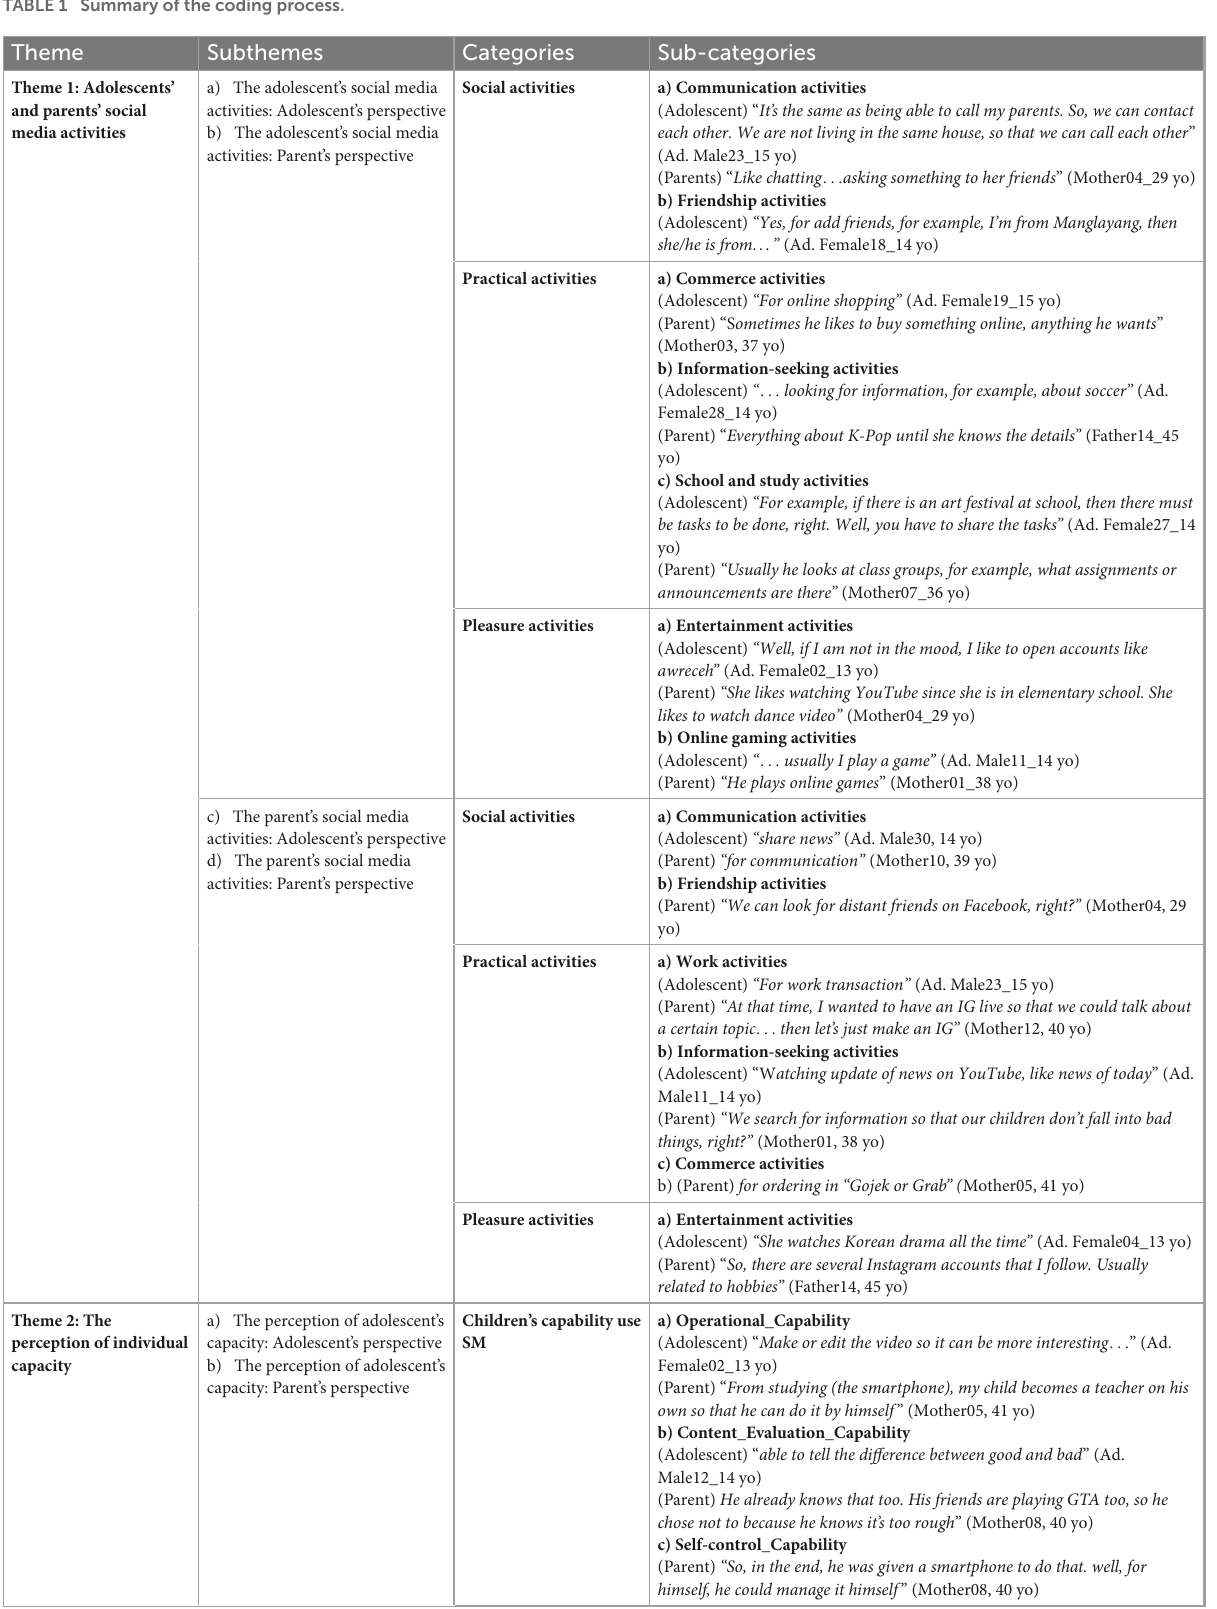
TABLE 1 Summary of the coding